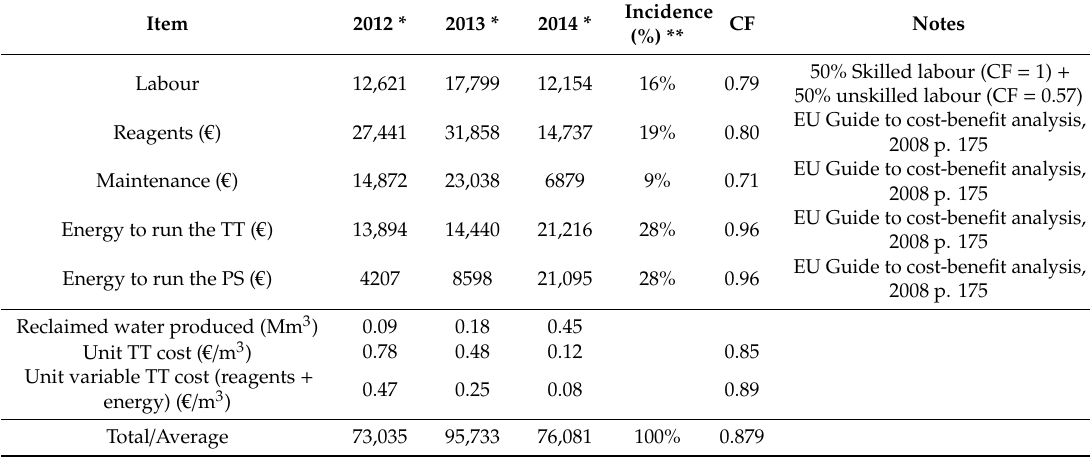
Table 2. O&M costs of the Gallipoli tertiary treatment plant and estimated Conversion Factors (CF) for the economic